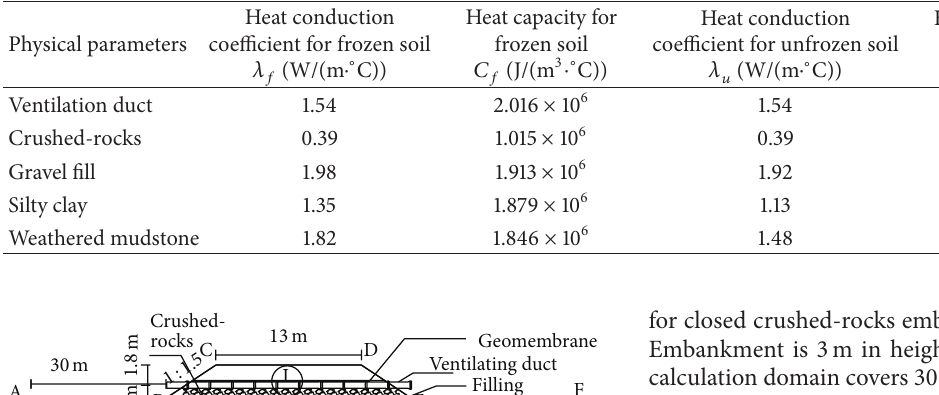
Table 1: Thermal parameters of various materials in and beneath the embankment.